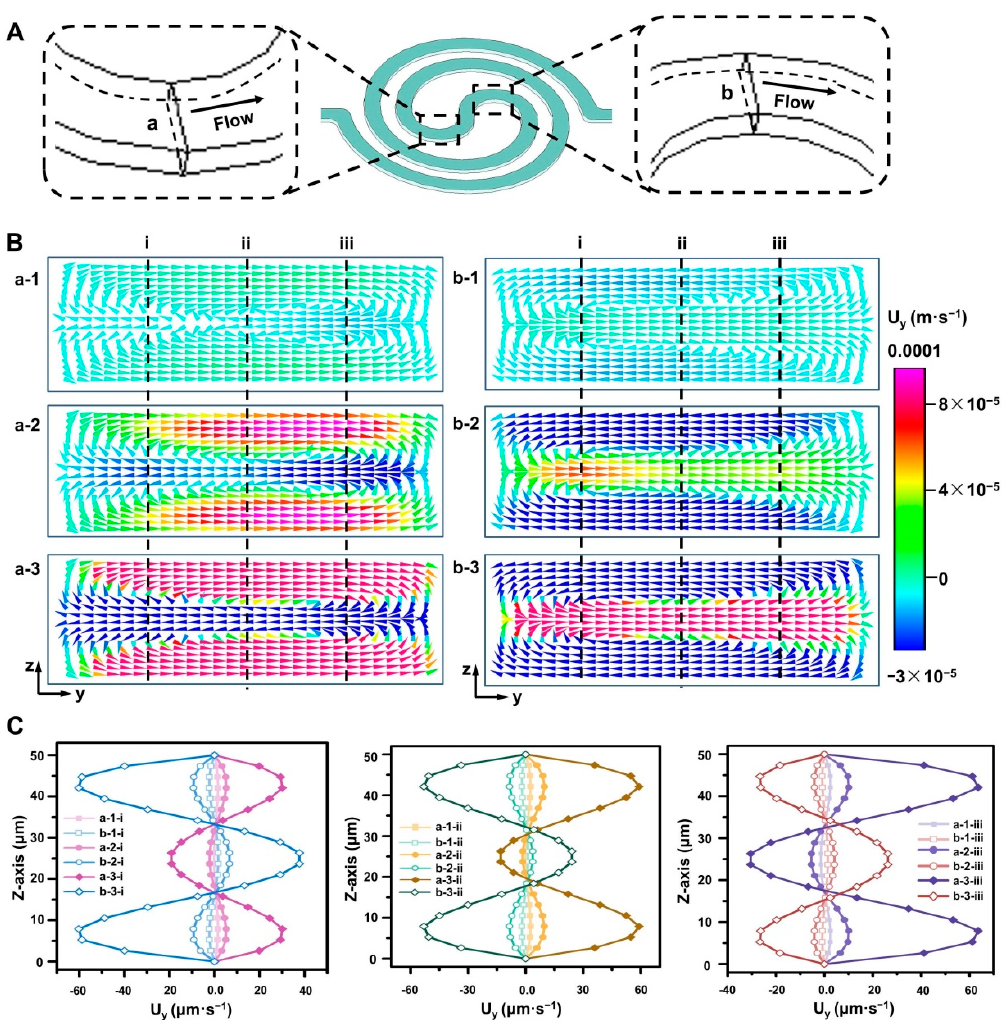
Figure 5. Dean flow induced by the double spiral mixer. ( A ) Schematic of the spiral mixer channel. ( B ) Computer simulation of Dean flow formations under different flow conditions. a and b respectively represent the fluid velocity field of the channel cross-section corresponding to the positions in Figure 5A. The flow rates are 10 μ L·min − 1 , 20 μ L·min − 1 , and 50 μ L·min − 1 (corresponding to the channel cross-sectional flow rates of a-1 and b-1, a-2 and b-2, and a-3 and b-3 in Figure 5B, respectively). ( C ) Quantitative analysis of Dean flow in the cross-section. The results were obtained at the positions shown by the dotted lines in Figure 5B.